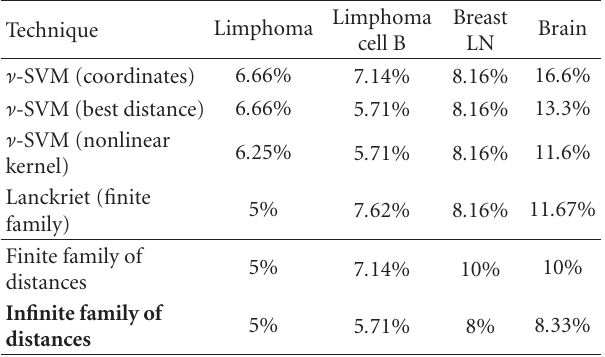
Table 2: Accuracy for the ν -SVM using a linear combination of non-Euclidean dissimilarities in an HRKHS. The ν -SVM based on the best distance and coordinates and the Lanckriet formalism have been taken as a